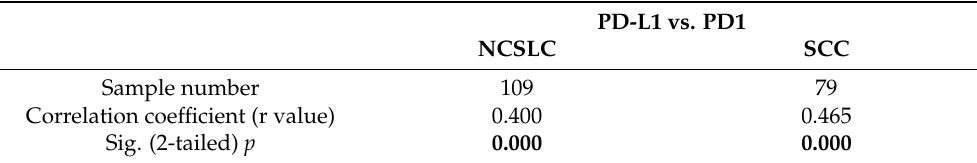
Table 4. Pearson correlation coefficients between PD-L1 and PD1 protein expression in primary lung tumor. PD-L1 vs. PD1 NCSLC SCC Sample number 109 79 Correlation coefficient (r value) 0.400 0.465 0.000